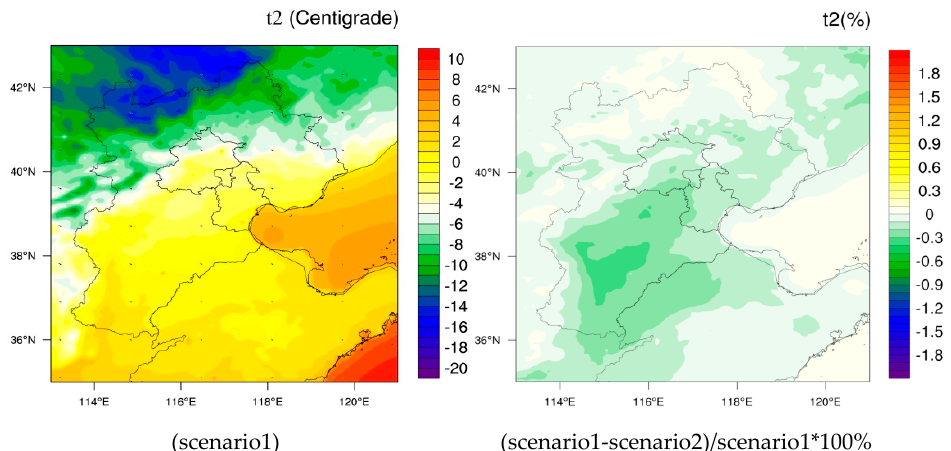
Figure 7. Simulated results of the effects of ARIs under different PM components on T2. Atmosphere 2020 , 11 , 254